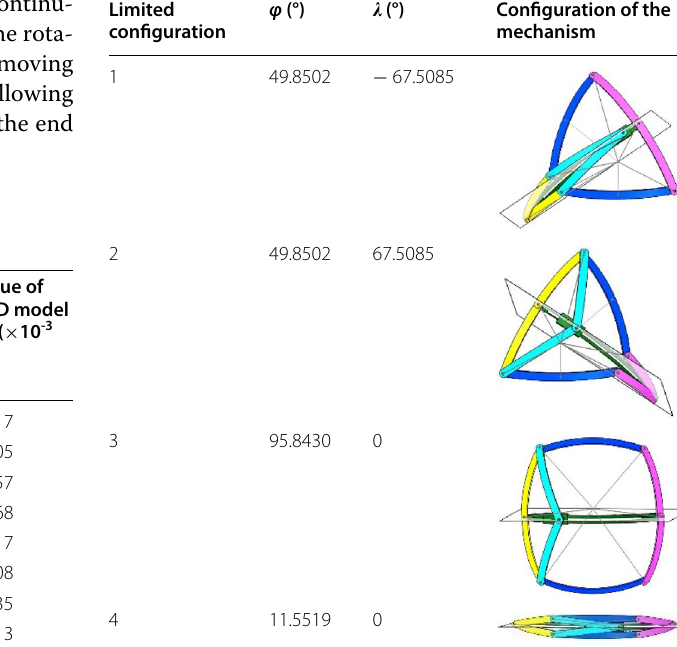
Table 2 Limited configuration parameters of the